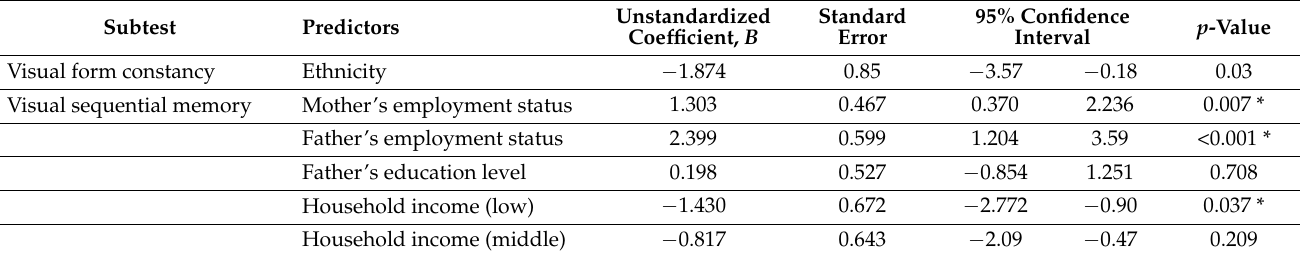
Table 5. Multiple regression analyses for the visual form constancy and visual sequential memory